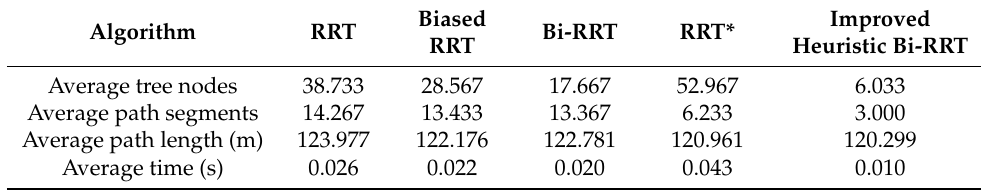
Table 3. Performance measures in the straight road scenario.